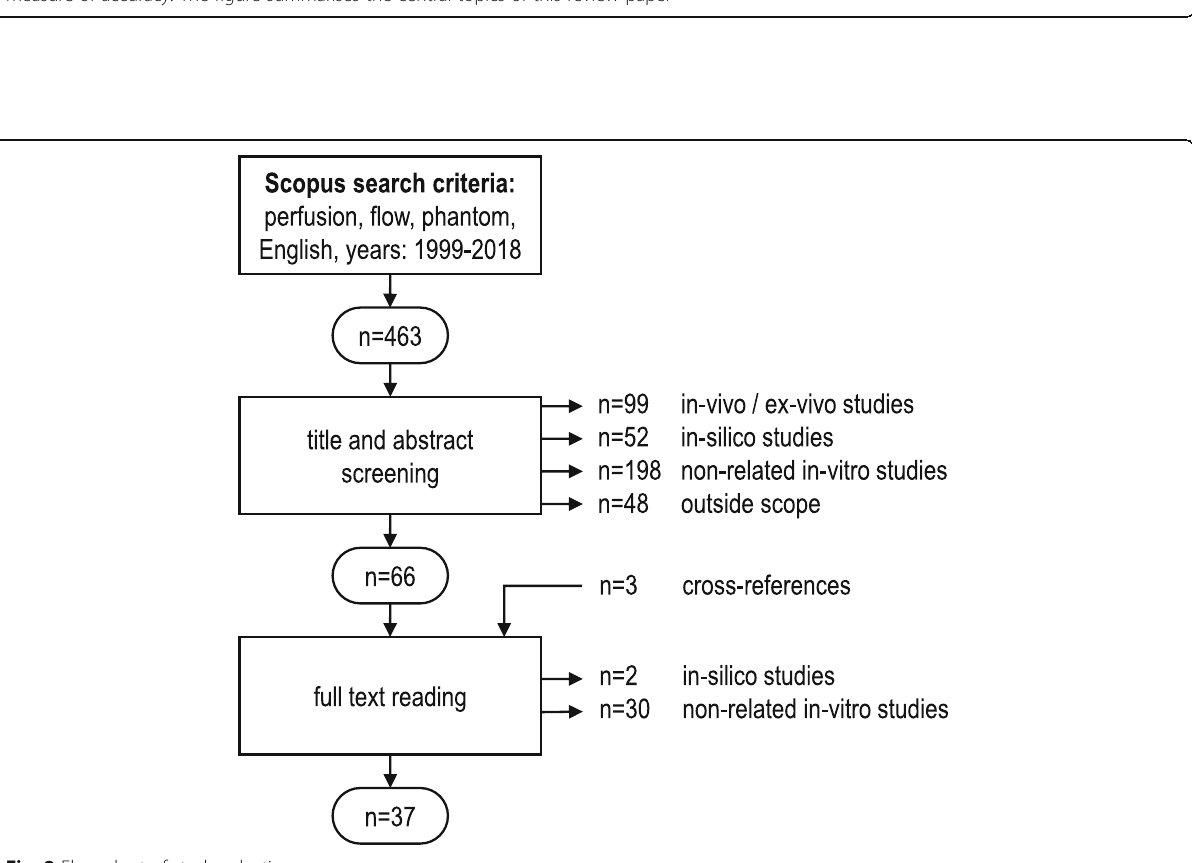
Fig. 1 System representation of ground truth validation process of quantitative perfusion imaging (PI). The diverse input variables that might affect quantitative perfusion outcomes are shown on the right. Q serves as an example input variable and refers to set phantom flow in mL/min. BF is accordingly the computed blood flow in mL/min (system output), and r is the residual between both. The latter can be translated into a measure of accuracy. The figure summarises the central topics of this review paper